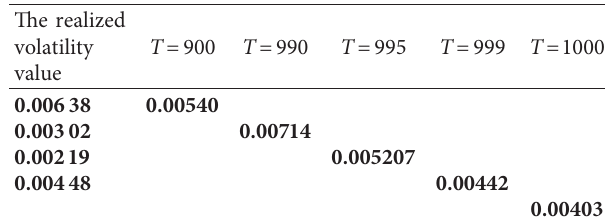
Table 5: One-step-ahead volatility prediction analysis of the fuzzy- EGARCH-ANN(1,1,2,1)